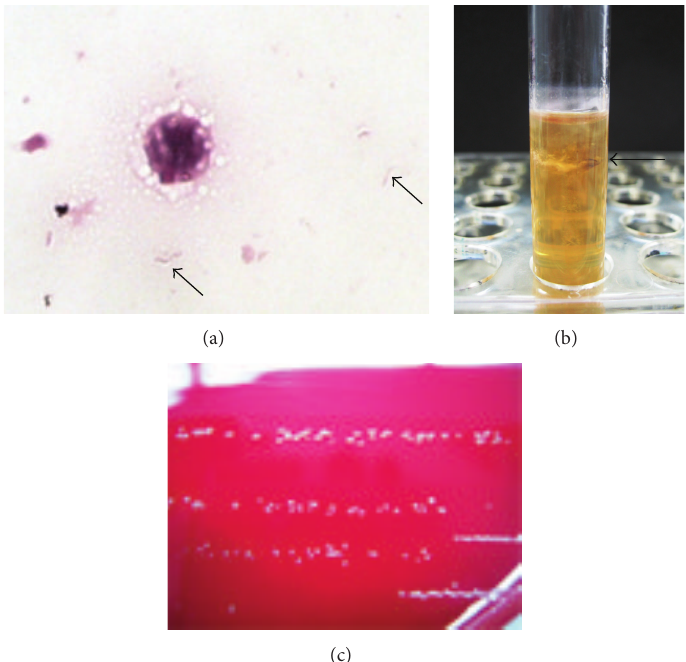
Figure 2: (a) Spiral-shaped bacteria (arrows) in broth from the anaerobic blood culture bottle. Gram stain; × 1000. (b) D. desulfuricans (arrow) grown in HK semisolid medium. (c) Colonies of D. desulfuricans on Brucella HK